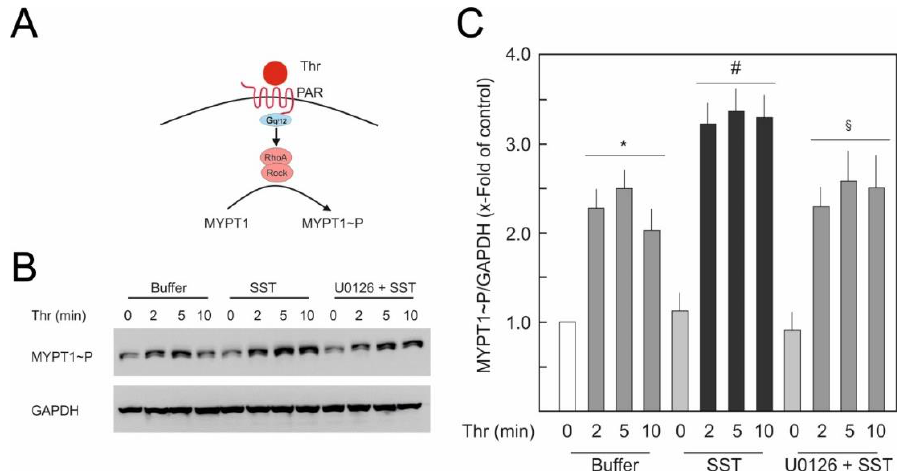
Figure 4. Effect of SST14 on RhoA/Rock pathways in HUVECs. (A) Schematic presentation of thrombin-mediated activation of RhoA/Rock signalling. (B) HUVECs were treated with thrombin (0.5 IU/mL) in the presence of buffer or SST14 (1 nM). Where indicated, cells were treated with U0126 (5 µM) for 30 min before treating with SST14 and thrombin. Representative Western blots of 3 experiments. (C) Quantification of blots from ( B) . p<0.05; * vs. control, # vs. Thr alone, § vs. SST+Thr.